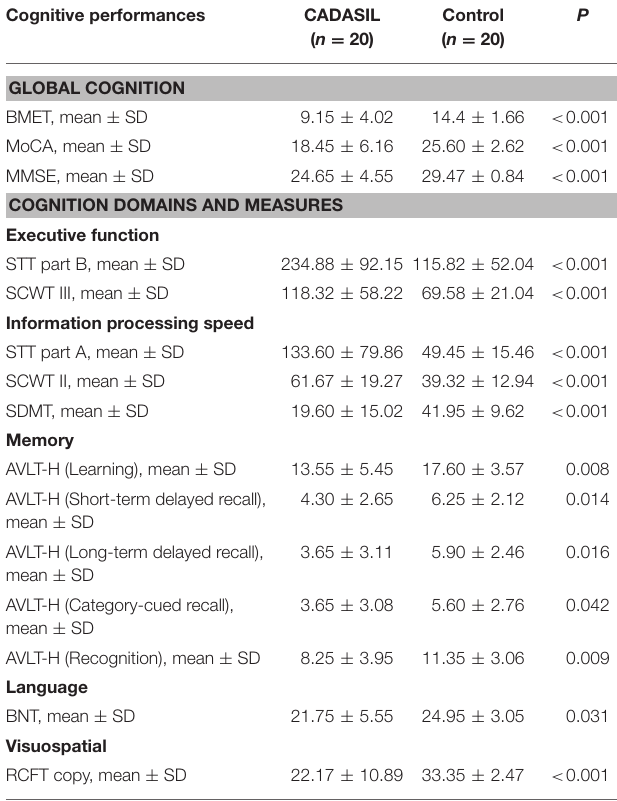
TABLE 2 | Cognitive performances of the CADASIL and the control groups. Cognitive